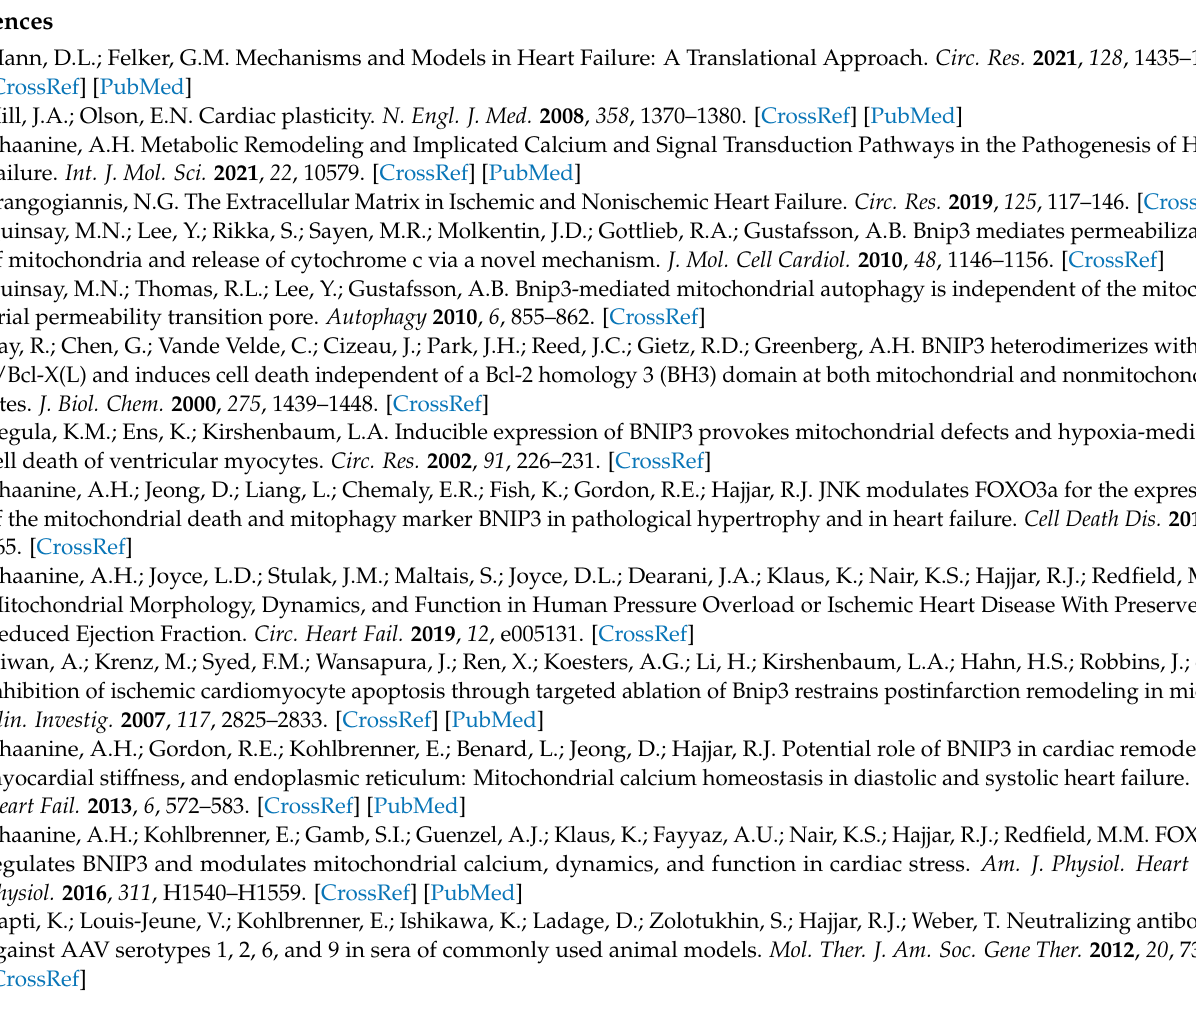
Table S1: Echocardiographic parameters of the animals that were studied in Sham, ShLuc and ShBNIP3 groups; Excel file S1: Proteomic LV and RV datasets; Excel file S2: Reactome